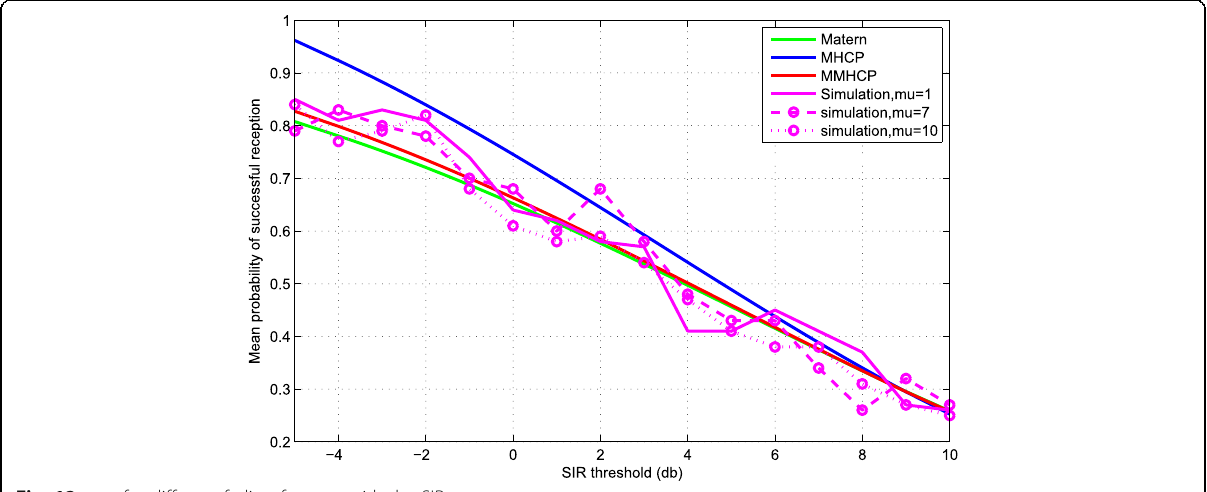
Fig. 12 e_ps for different fading factor μ with the SIR